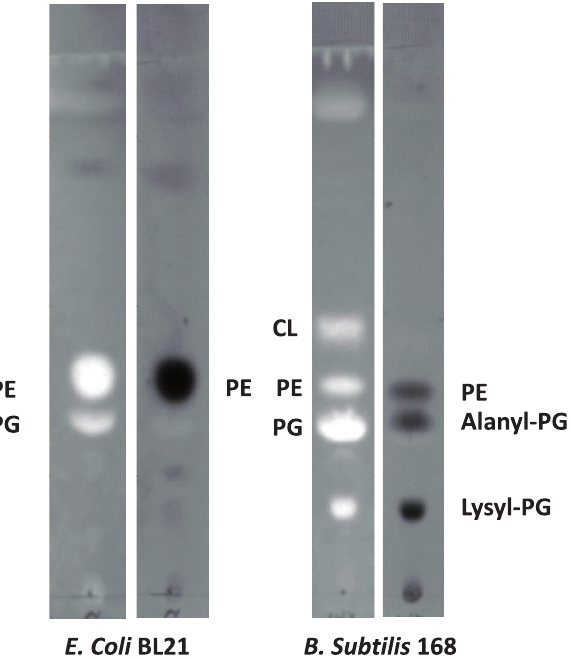
Figure 1. Thin-layer chromatogram of total lipids extracted from E. coli strain BL21(DE3) and B. subtilis strain 168. Major components of the bands are shown. Bright panels: Primuline- stained TLC sheet. Dark panels: Ninhydrin-stained TLC sheet. The fluorescent primuline (bright spots) is absorbed to hydrophobic molecules. Ninhydrin reacts with amino groups to produce purple products (dark spots). Lysyl-phospholipids form a distinct band with slow mobility. Alanyl-PG migrates slightly faster than PG, but significantly slower than PE. The Gram-negative E. coli has little